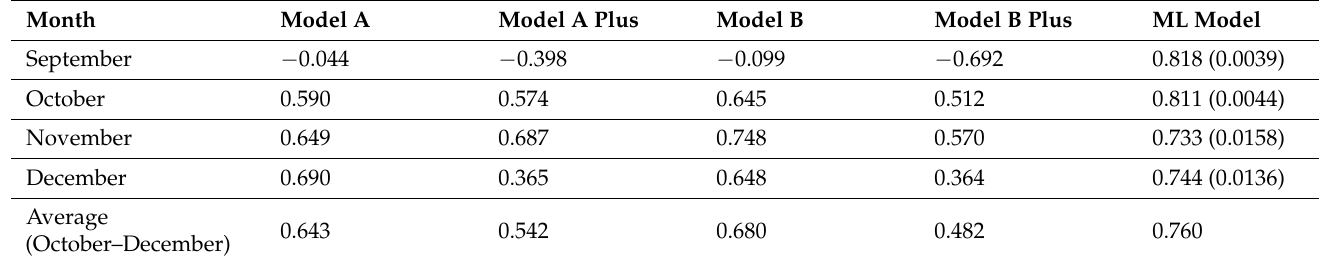
Table 4. Monthly Pearson correlation between the actual number of cholera cases and predicted cholera risk from all